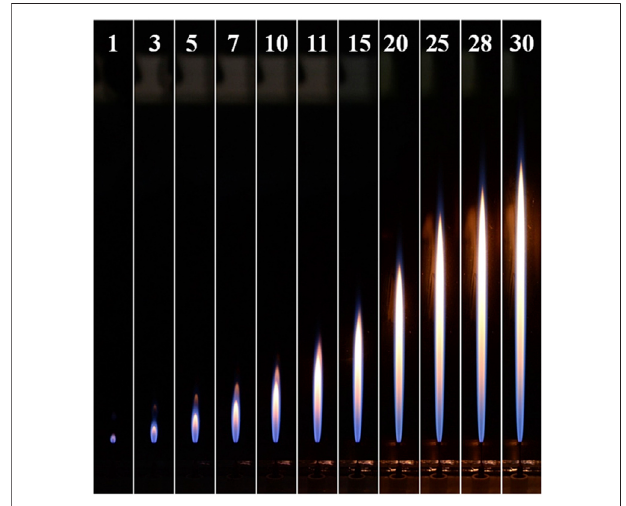
FIGURE 2 | The images of CH 4 -jet- fl ames in O 2 /CO 2 co fl ows with an oxygen mole fraction of 0.35. (The number on the top denotes the corresponding fuel fl ow velocity in the unit of